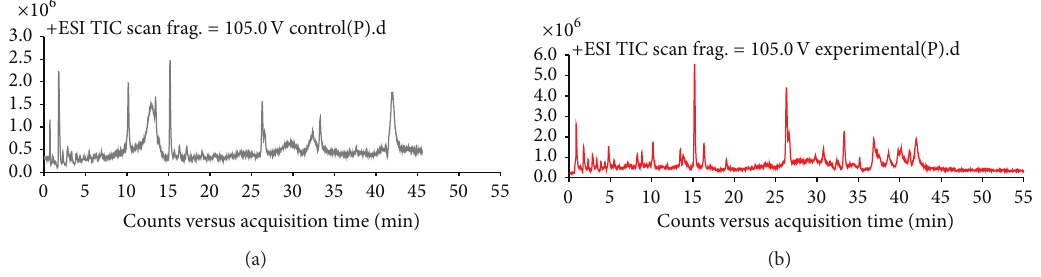
Figure 2: Total ion chromatograms of LC-MS analysis of Sanjin Tablet eluate. ESI ion mode: positive. Red line: Sanjin Tablet eluate. Gray line: water only control